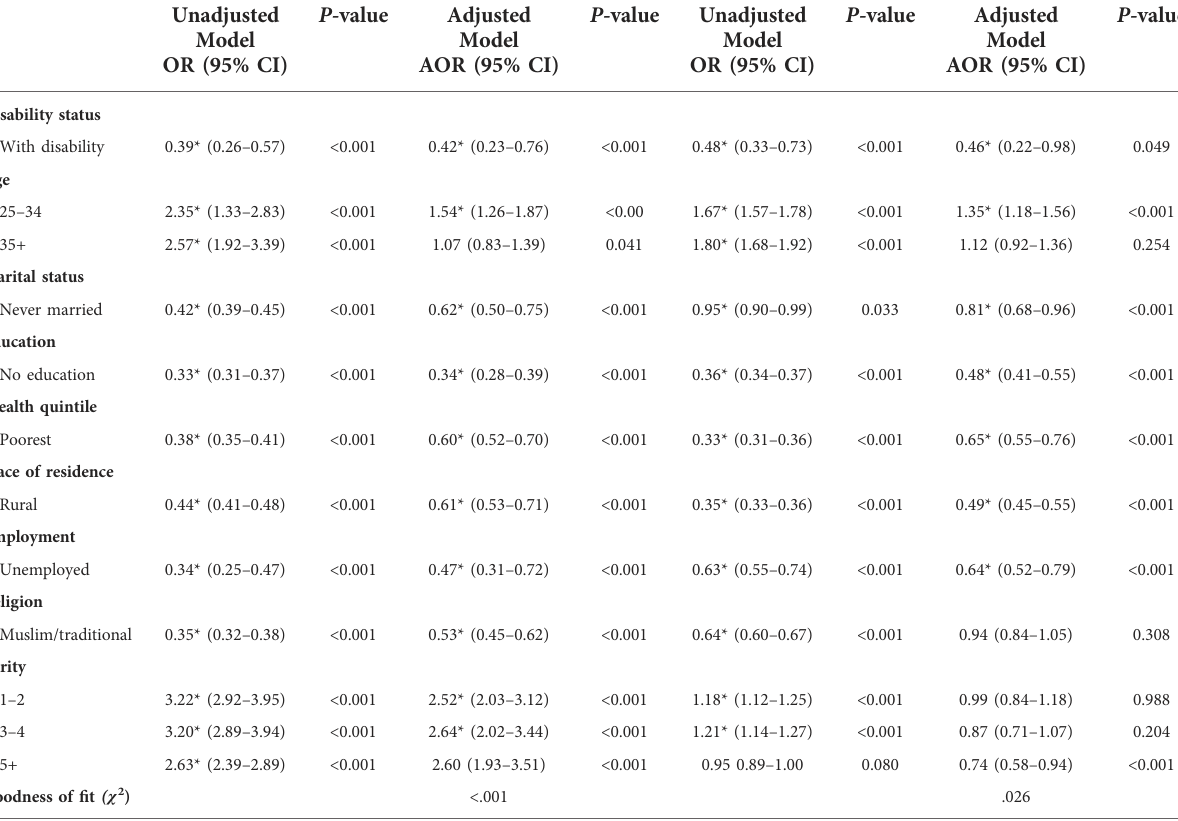
TABLE 3 Association between disability status and awareness of modern family planning method and receiving information about modern family planning methods. Awareness of modern family planning